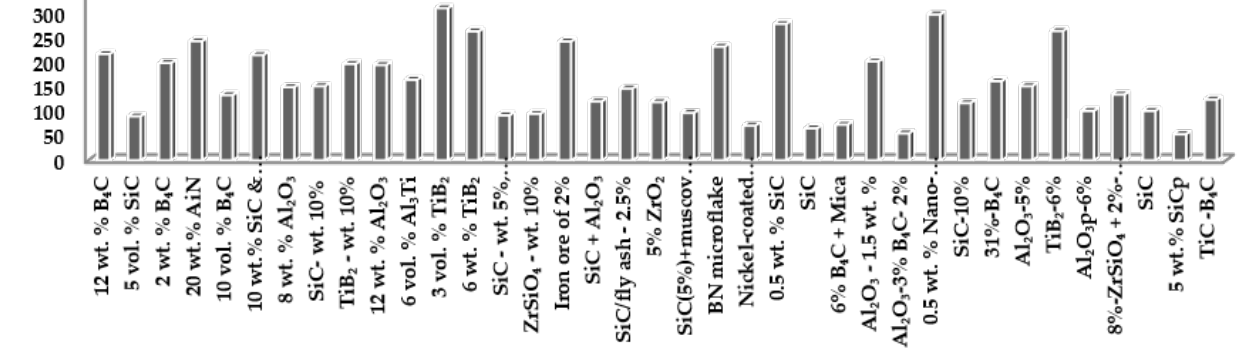
Figure 1. Graph of several reinforcements versus tensile strength [31–66].